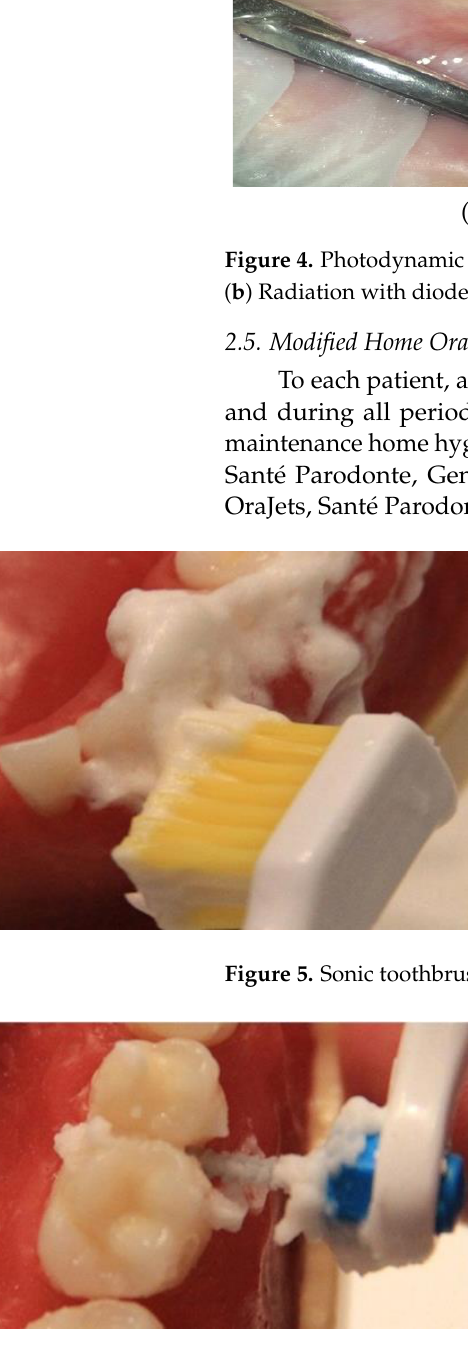
Figure 4. Photodynamic therapy without dye ( a ) Periodontal pockets irrigation with sioxyl solution; ( b ) Radiation with diode laser.